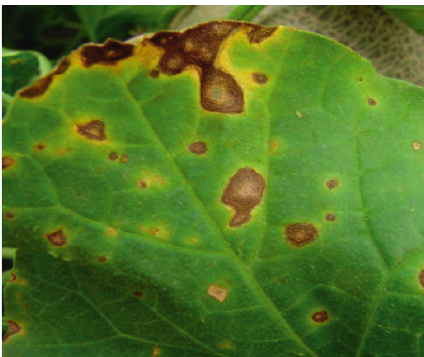
Figure 1: Alternaria leaf blight. Figure 2: Downy mildew.